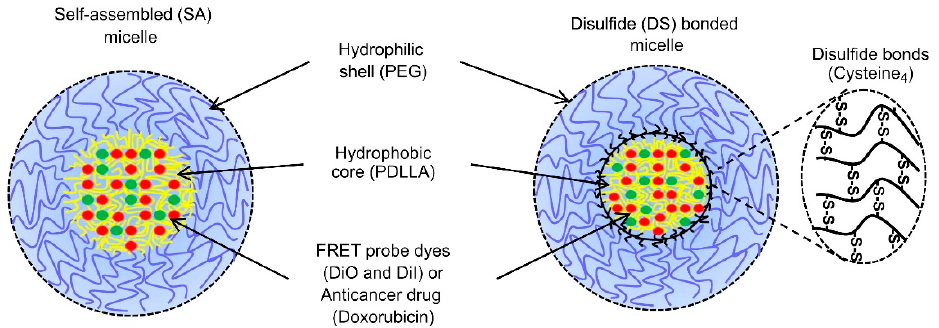
Figure 6. Schematic illustrations of self-assembled mPEG-PDLLA micelles and disulphide-bonded mPEG-(Cys)4-PDLLA micelles with FRET dyes (DiO and DiI). Reproduced with permission from ref. [11]. Copyright 2012, Elsevier Ltd., Amsterdam, Netherlands.